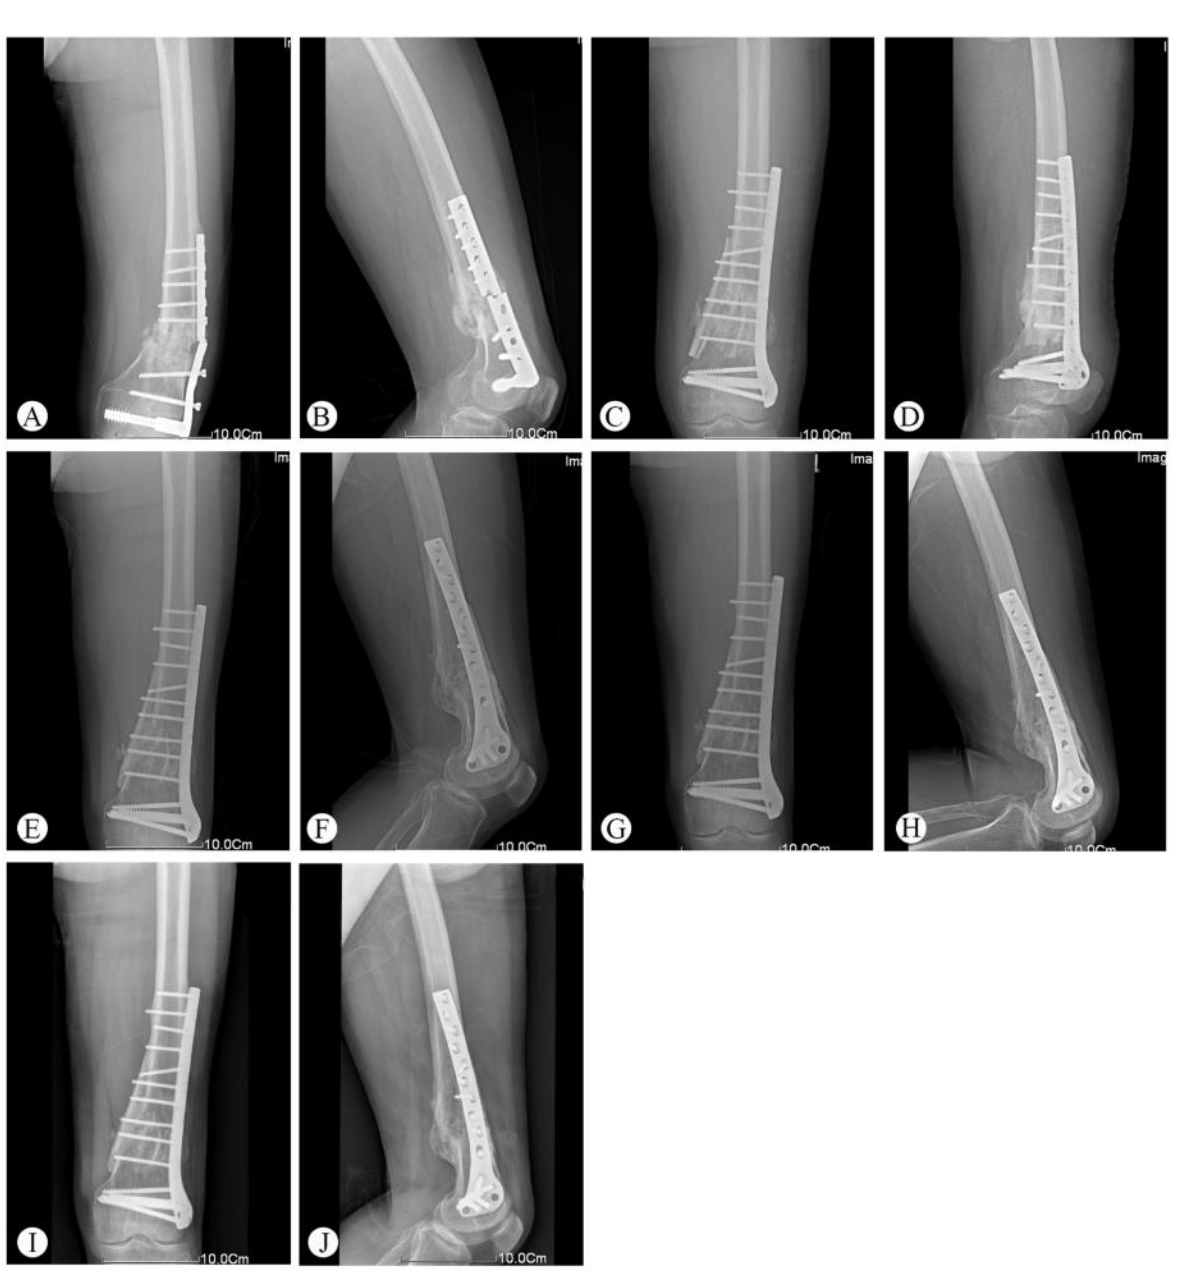
Figure 1. Representative images of Patient 2 (61-year-old male patient with a type A3 fracture that had been initially treated with dynamic condylar screws). ( A , B ) Implant breakage was observed seven months after surgery. ( C , D ) X-ray at 5 months after operation. Bone union was observed. ( E , F ) Follow-up X-ray at 36 months. ( G , H ) Follow-up X-ray at 60 months. ( I , J ) Follow-up X-ray at 73